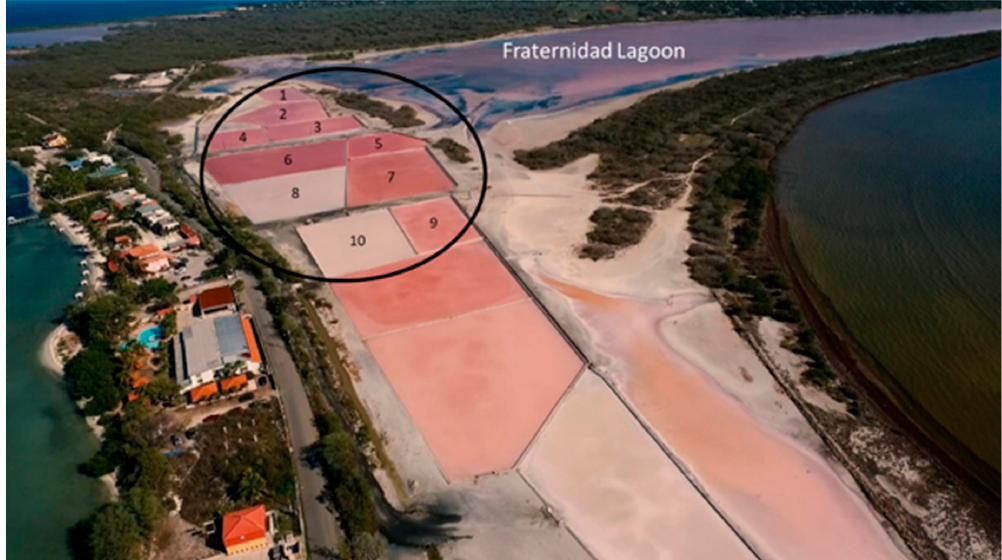
Figure 1. Aerial map of the Solar Salterns of Cabo Rojo (17°57'25.2"N, 67°11'58.0"W). Water samples (5 L) were obtained from ten crystallizers (circled in black) and pooled together into one sample (50 L). Three samplings were performed on the same crystallizers in rainy (December 2014), and dry (March and July 2016) seasons. Photo taken by “Puerto Rico desde el Aire” reproduced with permission.